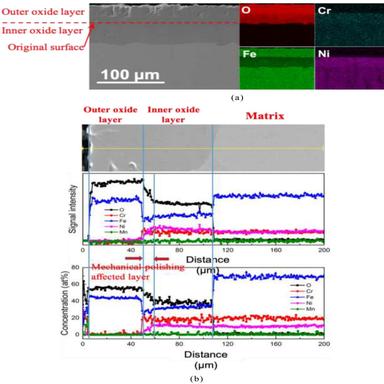
(a) SEM-EDX elemental maps showing a double-layered surface oxide scale: a Fe-rich outer oxide layer and a Cr-rich inner oxide layer; (b) EDX line-scan showing the quantitative and qualitative distribution of chemical composition across the surface oxide film.